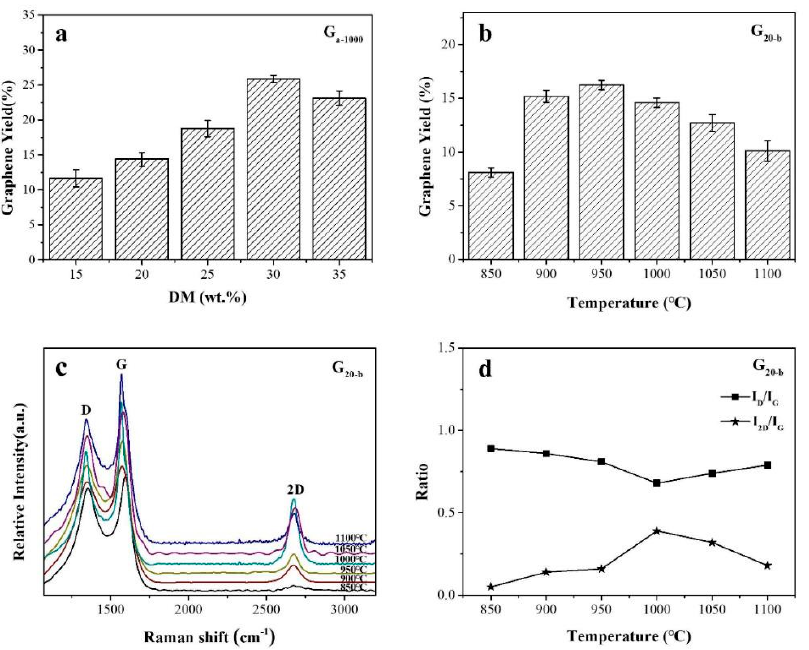
Figure 2. ( a ) Effects of DM content on the yield of G a-1000 ; ( b ) effects of pyrolysis temperature on the yield of G 20-b ; ( c ) Raman spectra of G 20-b ; ( d ) effects of pyrolysis temperature on I D /I G and I 2D / G ratios of G 20-b